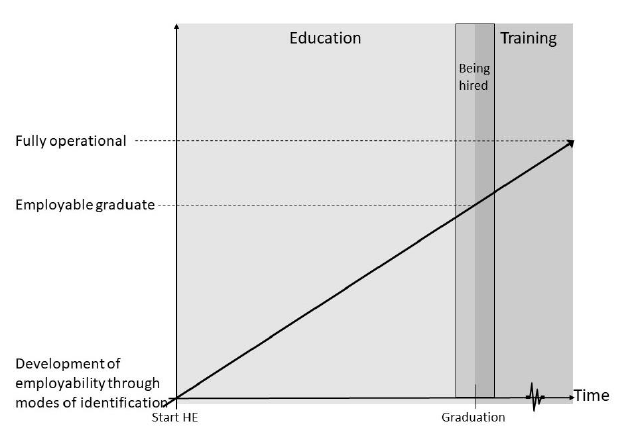
Fig. 1. Developing employability through modes of identification from the beginning of higher education until fully operational in a